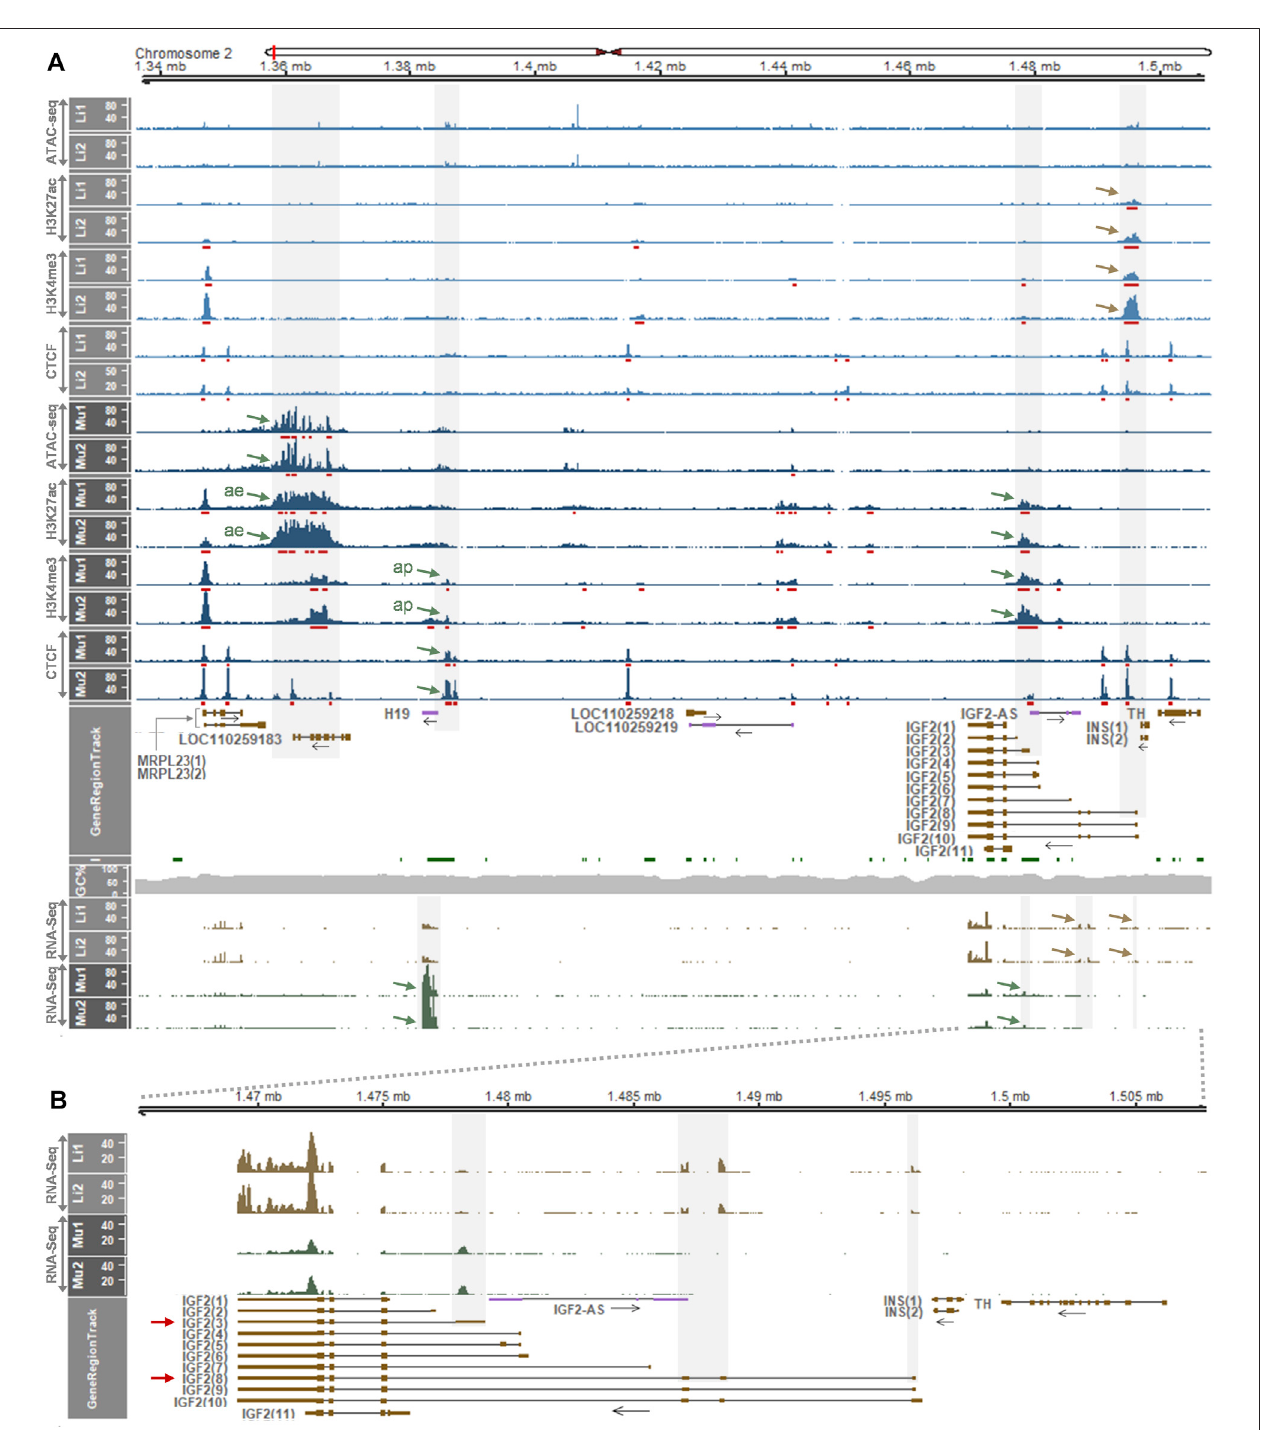
FIGURE 2 | Epigenetic regulatory elements identi fi ed in the H19/IGF2 locus of liver and skeletal muscle of 6-month-old pigs and gene expression pro fi ling. (A) Above GeneRegionTrack, peaks of ATAC-seq, H3K27ac, H3K4me3 and CTCF are displayed in 1x normalized read coverages. MACS2-called peaks are underscored with red bars. Peaks of interest in the liver and skeletal muscle are pointed with brown and blue arrows, respectively. ae, active enhancer; ap, active promoter. Below GeneRegionTrack, normalized read coverages in TPM values from RNA-Seq from the same pigs (P348 and P350) are displayed. Li1, liver 1 from P348; Li2, liver 2 from P350; Mu1, skeletal muscle 1 from P348; Mu2, skeletal muscle 2 from P350. (B) RNA-Seq read coverages in the IGF2 locus are zoomed in. Data were retrieved from a dataset (GSE158430). Details about y axis titles and the plot are in Figure 1 legend.